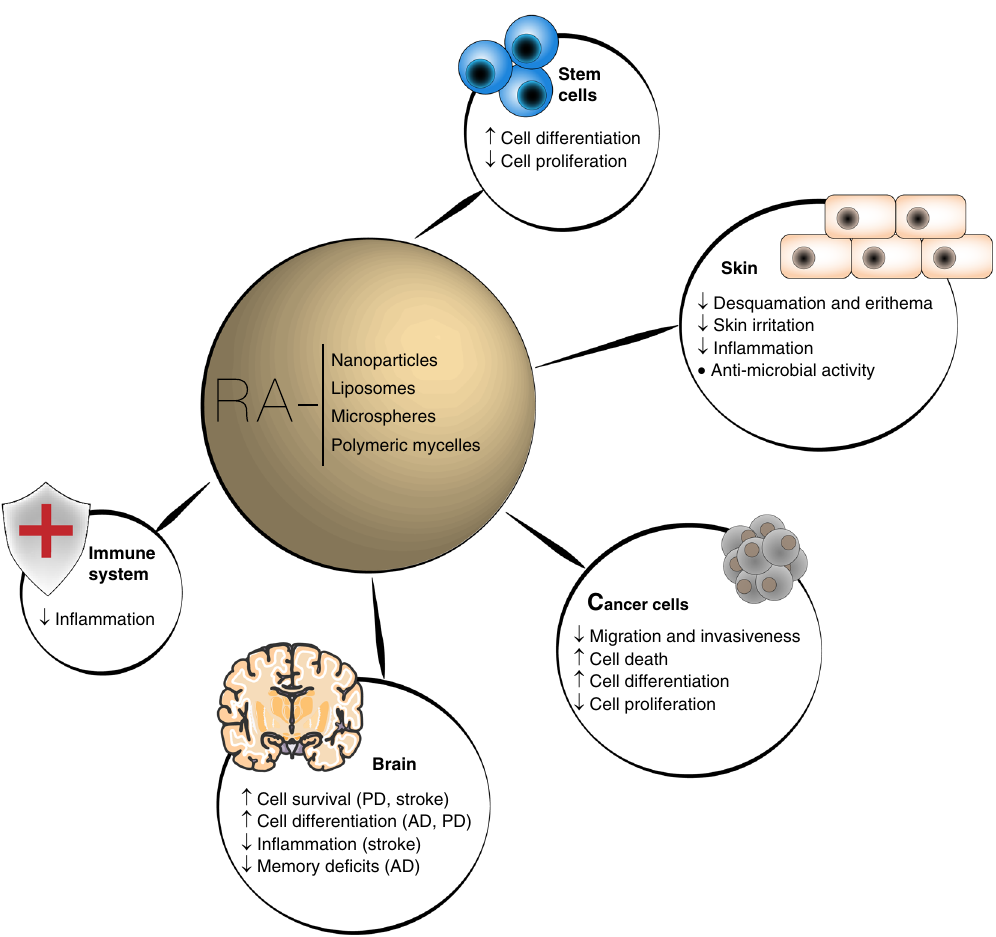
Fig. 3 Main outcomes of RA-based therapies in pathological contexts. AD Alzheimer ’ s disease, PD Parkinson ’ s disease, RA retinoic acid, ↑ = increased effect, ↓ = decreased effect, ● = regulatory